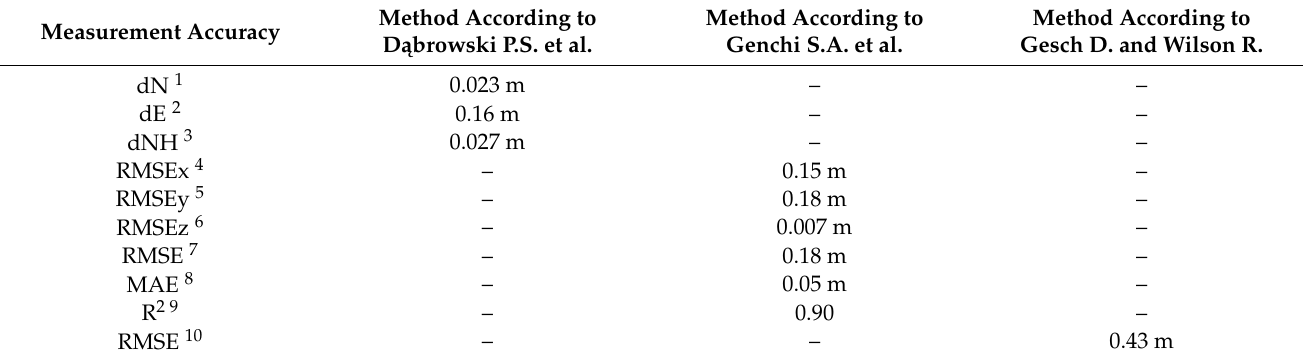
Maximum difference in Northing 1 , Easting 2 and normal height 3 coordinates with respect to reference points. RMSE of x 4 , y 5 and z 6 coordinates with respect to the SfM model and 7 GCPs. RMSE 7 , MAE 8 and R 29 with respect to the BPC and TPC models. RMSE 10 with respect to the bathymetric grid and reference transect